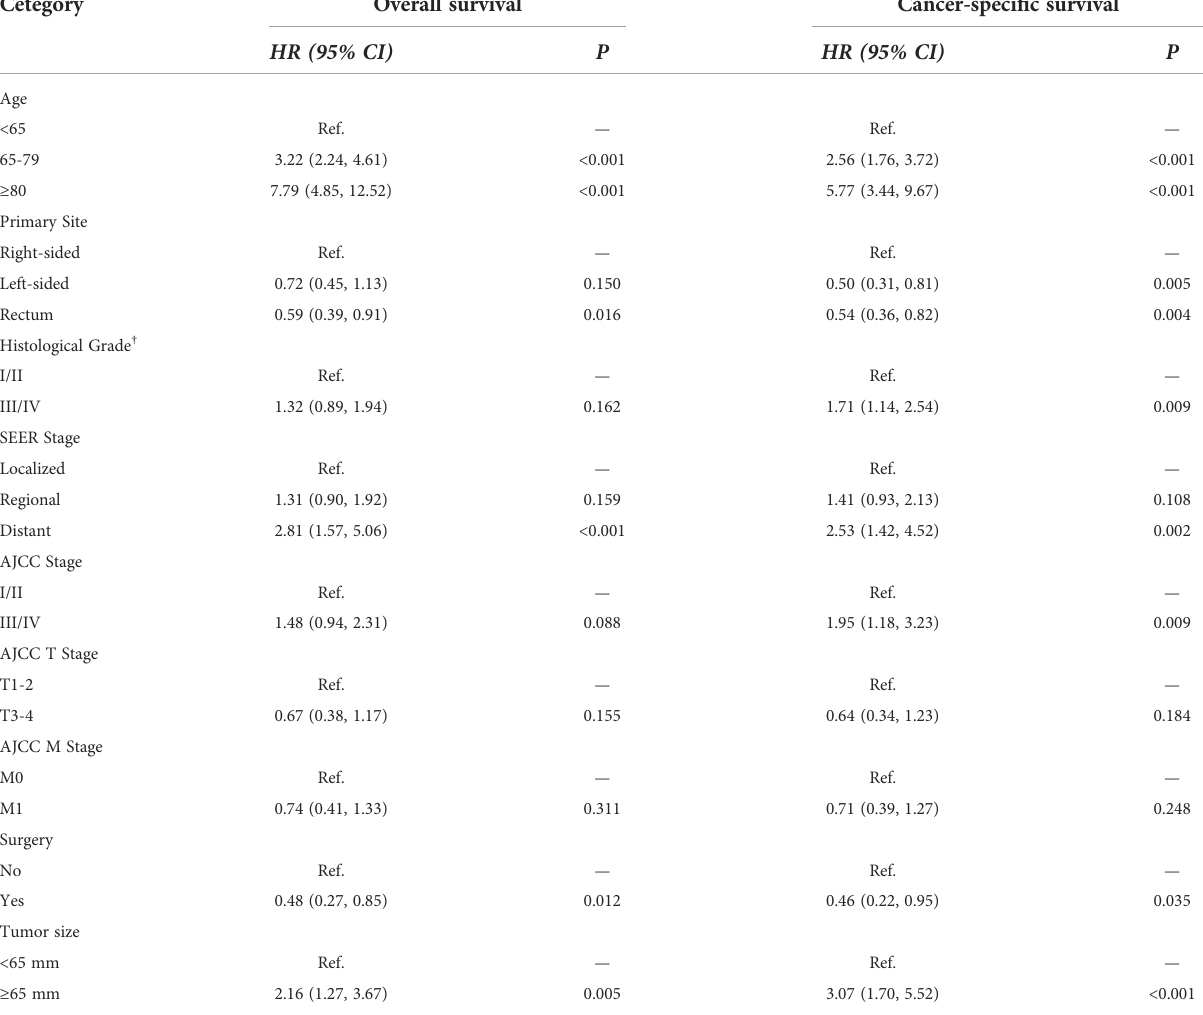
TABLE 3 Multivariate analysis for Overall survival and Cancer-speci fi c survival in training cohort.